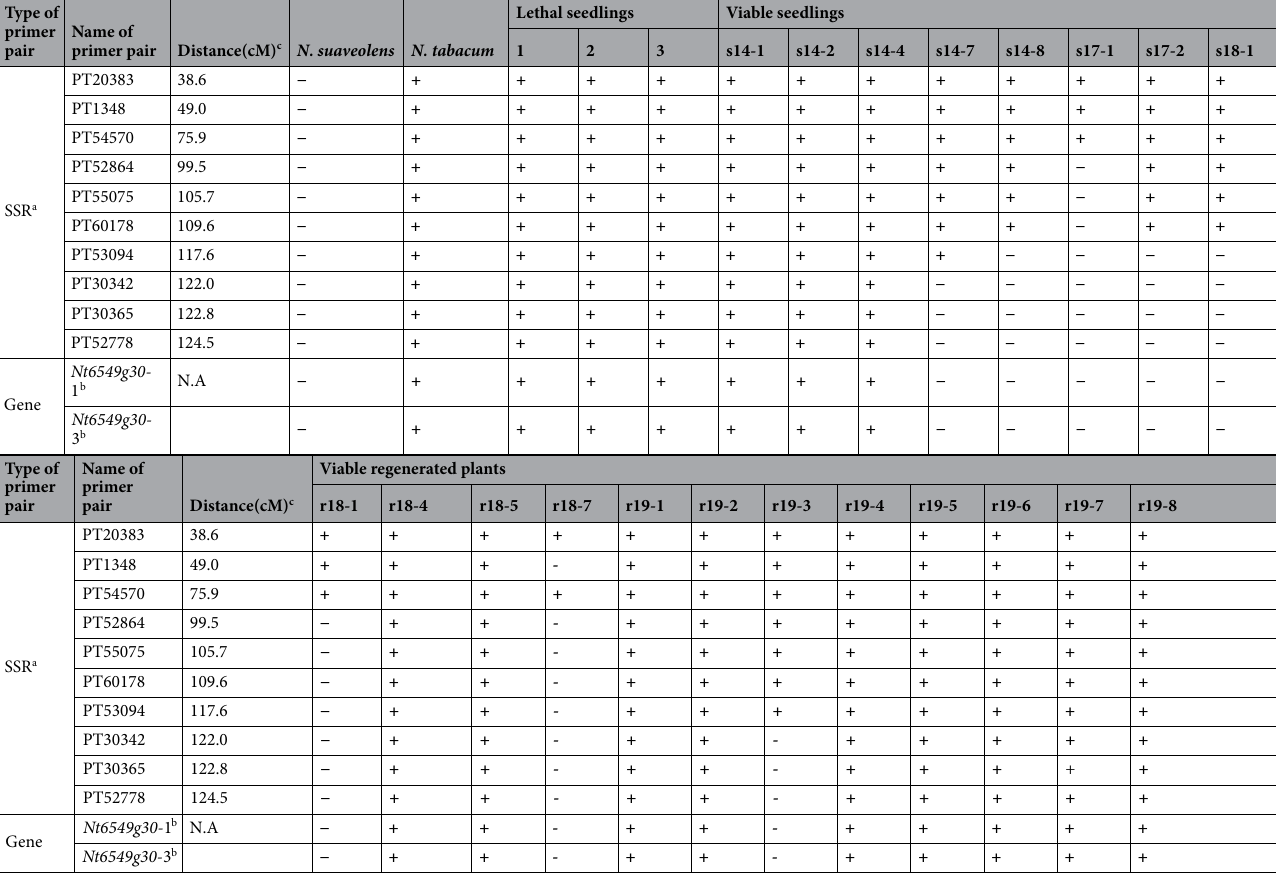
Table 1. Detection of products, amplified by SSR and Nt6549g30 primer pairs, from the Q chromosome (Linkage group No. 11) of N. tabacum in lethal seedlings, viable seedlings, and viable regenerated plants of the N. suaveolens × N. tabacum cross. ‘ + ’ indicates the presence of allele of N. tabacum , ‘-’ indicates the absence of allele of N. tabacum . N.A., not applicable. a Bindler et al. 43,44 . b Closely linked to PT30342, as confirmed